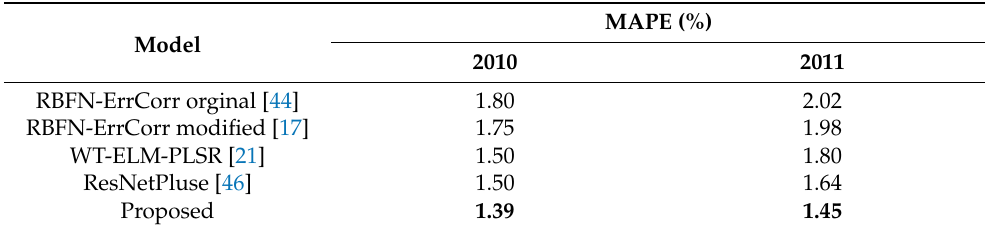
Table 8. MAPEs of the proposed model with the ISO-NE dataset in Test Case 2.